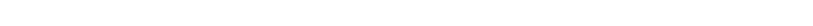
Table 1. Specification of systematic mapping.